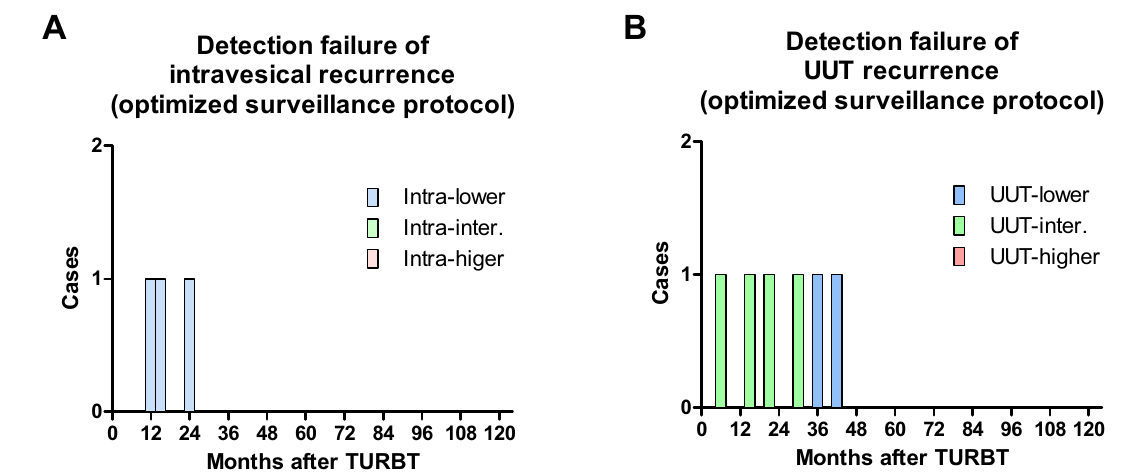
Figure 4. Detection failure of recurrence. The number of patients who potentially failed in intravesical ( A ) and upper urinary tract (UUT) ( B ) recurrence detection using the optimized surveillance protocols. TURBT, transurethral resection of bladder